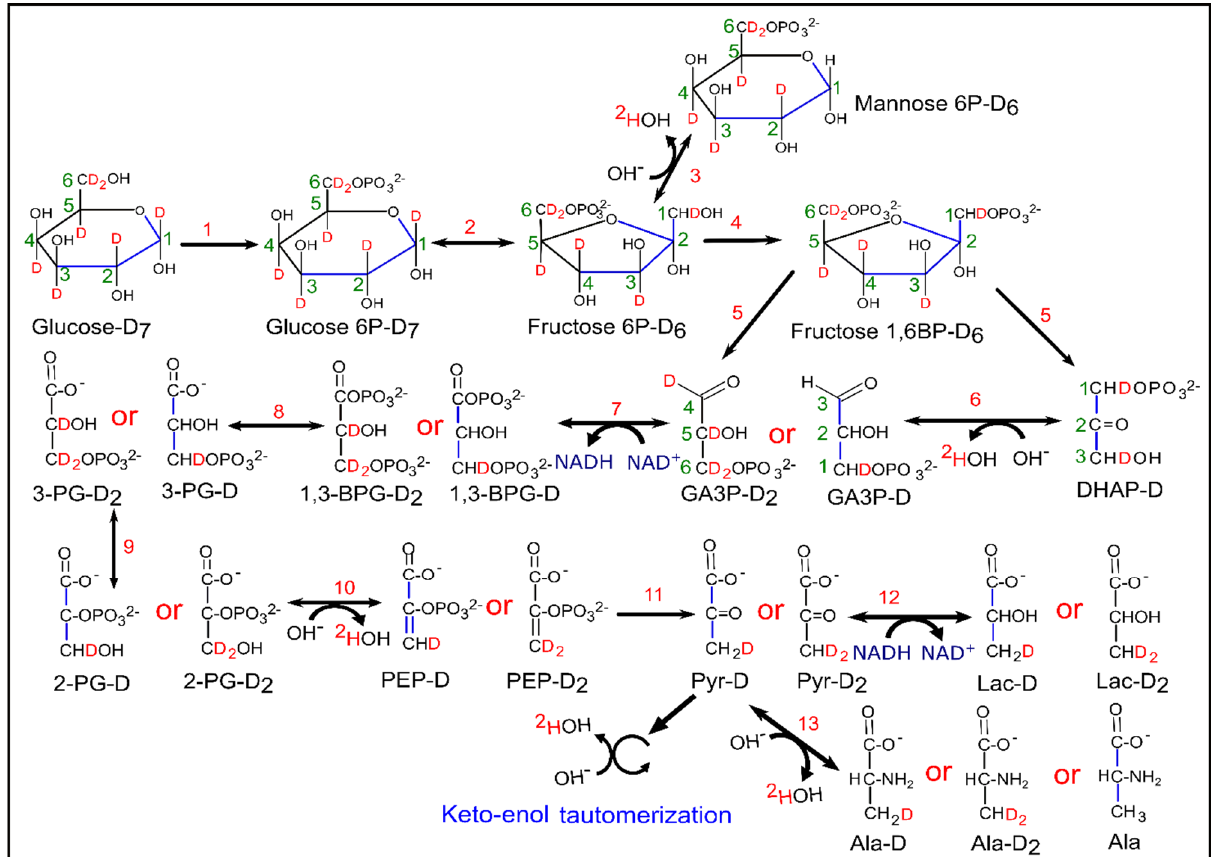
Figure 7. Schematic diagram of glycolysis and evolution of HDO from [ 2 H 7 ]glucose. Enzymatic reactions indicated by numbers in the figure were catalyzed by (1) hexokinase, (2) phosphoglucose isomerase, (3) phosphomannose isomerase, (4) phosphofructokinase, (5) aldolase, (6) triose phosphate isomerase, (7) glyceraldehyde 3-phosphate dehydrogenase, (8) phosphoglycerate kinase, (9) phosphoglyceromutase, (10) enolase, (11) pyruvate kinase, (12) lactate dehydrogenase and (13) alanine amino transferase. (Note: number of deuterons, which ends up in the methyl group of lactate isotopomers were written with the name of lactate precursors from GA3P-D and GA3P-D 2 onwards).